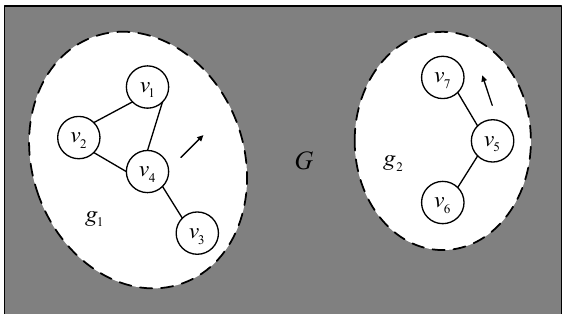
Figure 4. Graphical representation of groups. Seven moving targets belong to two groups. The arrow shows the direction of movement of the group. Note that there is no edge between v 6 and v 7 . However, they are in the same group because of the common connection with v 5 .